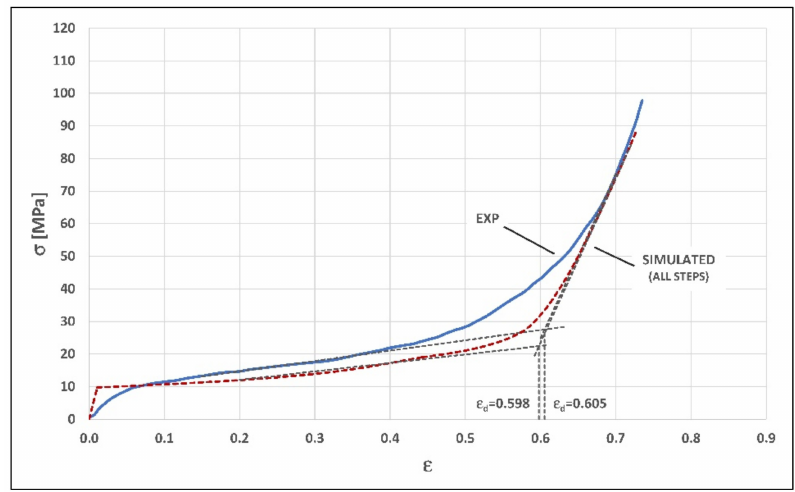
Figure 15. Comparison between experimental curve and predictive simulated curve (0.1% TiH 2 foam).